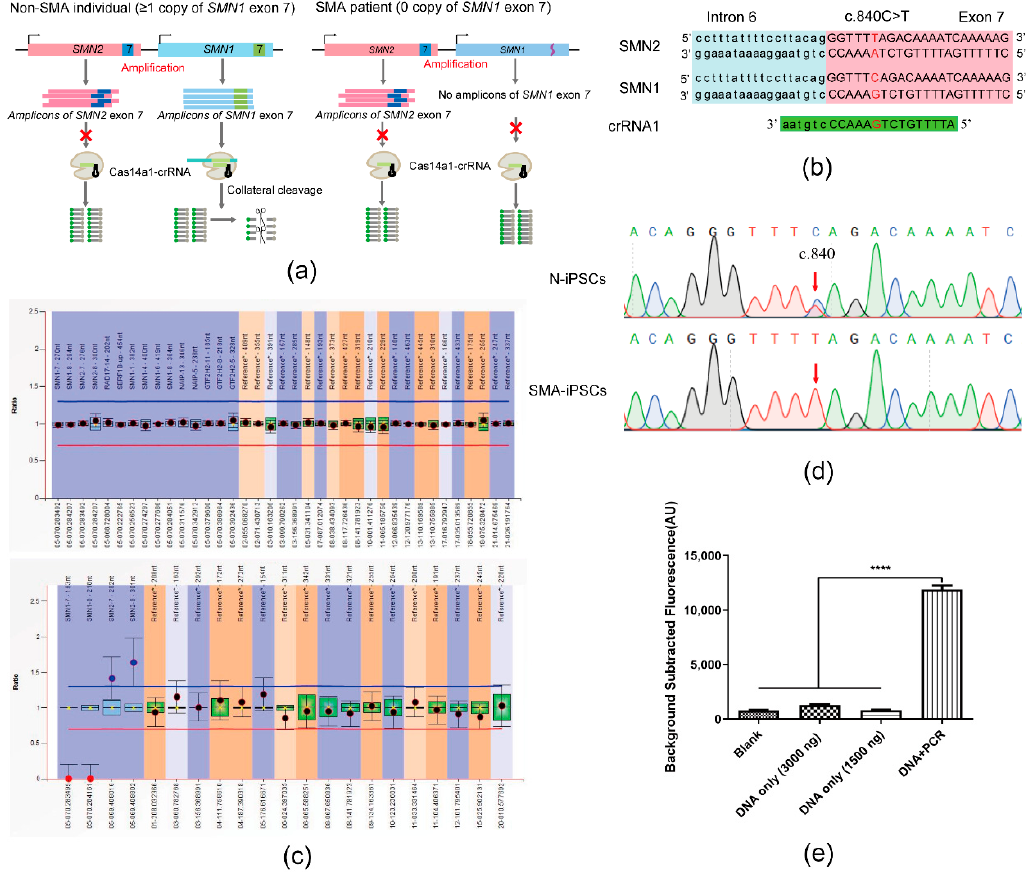
Figure 2. SMA-Cas14a1 Fluorescence Detection System. ( a ) Schematic illustration of SMA-Cas14a1 fluorescence detection system. The CRISPR RNA (crRNA) targeted exon 7 of SMN1 . In non-SMA individuals, SMN1 exon 7 triggers Cas14a1 activation after being recognized by the Cas14a1/crRNA complex, and activated Cas14a1 degrades the vicinal fluorescence probe nonspecifically, yielding fluorescence through acquired collateral cleavage activity. The Non-SMA individual included the SMA carrier with one copy of SMN1 exon 7 and the normal individual with more than one copy of SMN1 exon 7. However, SMA patients lack SMN1 exon 7, which is required to activate Cas14a1, and thus no fluorescence is generated in this case. ( b ) Schematic representation of the position and sequence targeted by crRNA1. ( c ) MLPA results of N-iPSCs and SMA-iPSCs. ( d ) Sanger sequencing results of the PCR products of N-iPSCs and SMA-iPSCs using primers F1/R1. ( e ) Comparison of fluorescence in different groups: 3000 ng of DNA without amplification, 1500 ng of DNA without amplification, DNA amplified using PCR, and blank control. Data are means ± SEM; **** p <